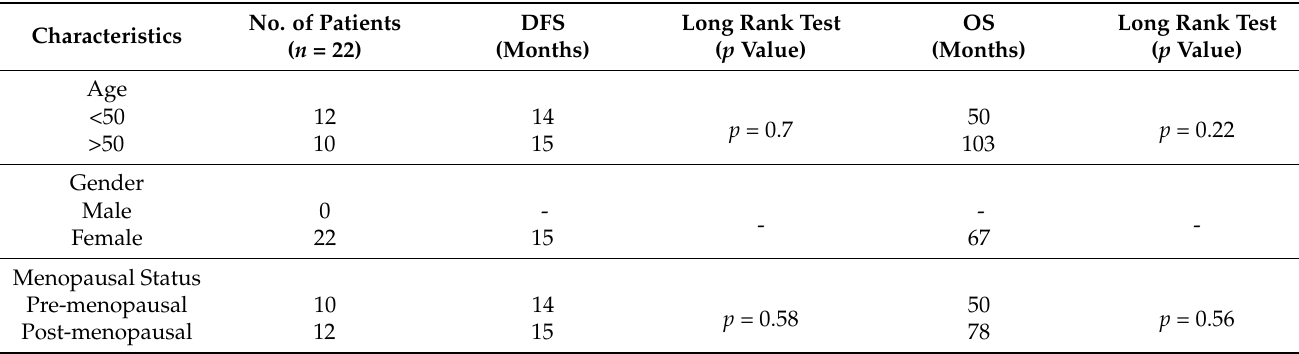
Table 1. Demographic and clinicopathological characteristics of patients ( n = 22) and correlation with the disease-free interval (DFI) and overall survival